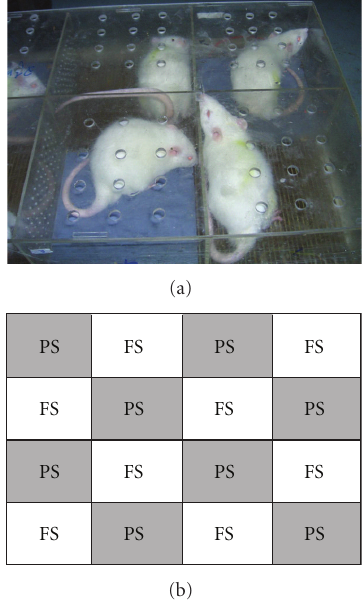
Figure 1: The communication box used in the experiment. (a) Photos of the communication box with rats inside. The grid floors of the psychological compartment were covered by blue plastic plates. (b) Schematic diagram of the communication box. FS refers to the foot-shocked group, and PS refers to the psychological stress